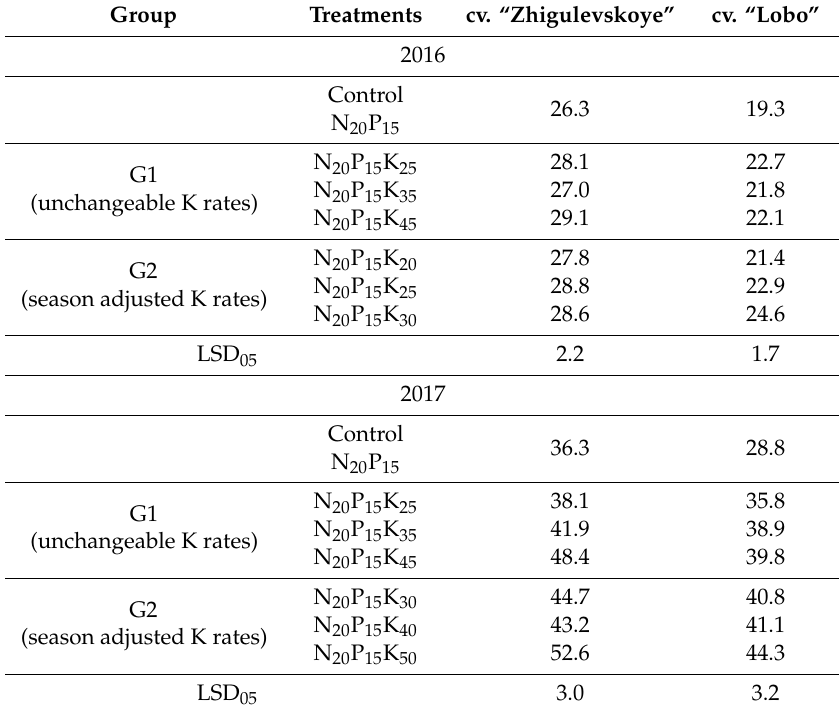
Table 8. E ff ect of various potassium fertilization rates and fertigation approaches on apple yield, T ha − 1 . Group